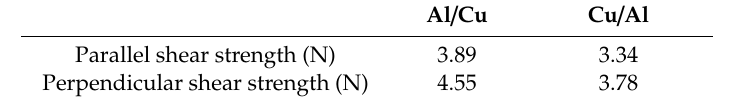
Table 11. The parallel and perpendicular shear strength of Al / Cu and Cu / Al.